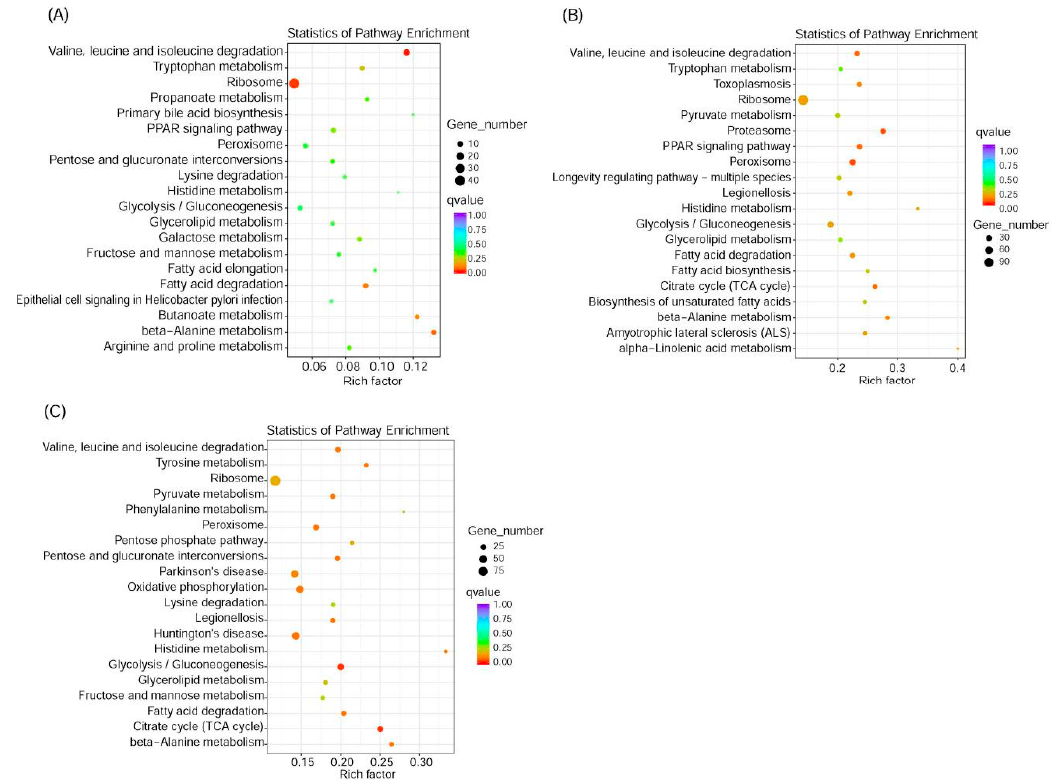
Figure 2. Enrichment scatter diagram of KEGG pathways at different time points. ( A ) at 6 h of fluazinam treatment compare to control, up: 28 genes, down: 487 genes; ( B ) at 24 h of fluazinam treatment compare to control, up: 368 genes, down: 1997 genes; ( C ) at 48 h of fluazinam treatment compare to control, up: 191 genes, down: 1381 genes.